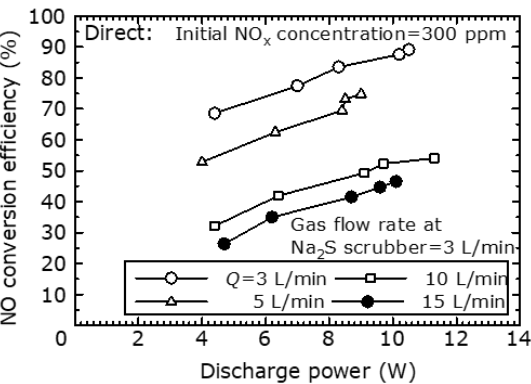
Figure 6. NO conversion efficiency varying with the discharge power at different flow rate by the direct oxidation method.